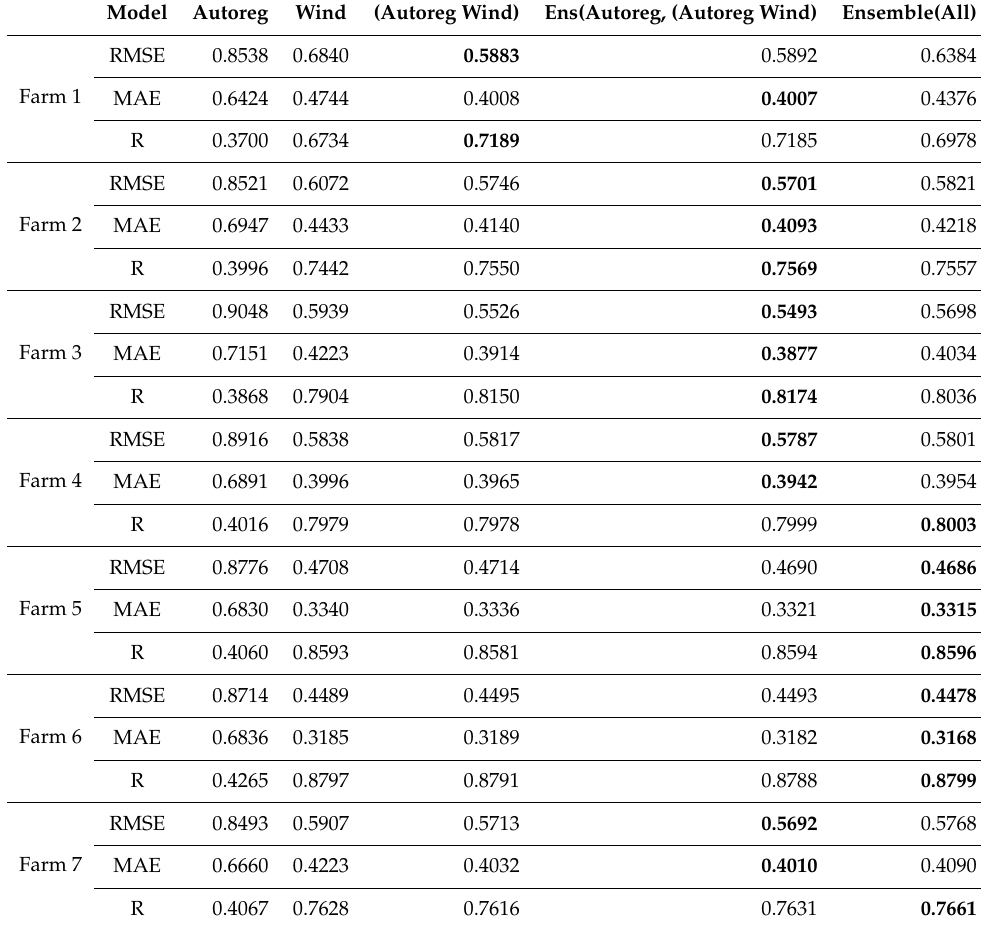
Table 3. Obtained performances for each of the evaluated wind